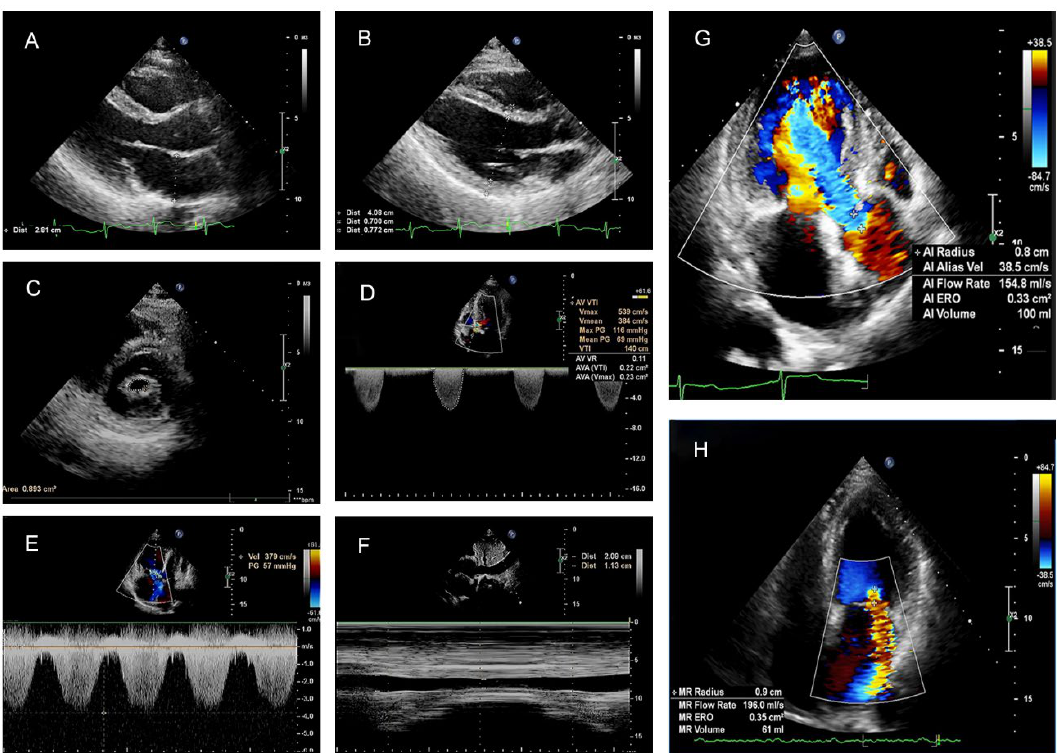
Figure 2. Representation of measured values based on echocardiographic views. ( A ) The measure- ments of the left atrial in parasternal left ventricular long axis (PLAX) view. ( B ) The measurements of the interventricular septum (IVS), left ventricular posterior wall (LVPW), and left ventricular end-diastolic diameter (LVEDD) in PLAX view. ( C ) Measurement of the mitral valve area in a patient with rheumatic heart disease; the mitral valve area was manually outlined and the mitral valve area is 0.89 cm 2 . ( D ) The aortic valve area was calculated using continuity equations, and the effective valvar orifice area (EOA) of the aortic valve is 0.23 cm 2 . ( E ) A continuous wave Doppler was used to measuring the end-expiration peak velocity of the tricuspid regurgitant (TR) jet. ( F ) The IVC size was measured in M-mode at the subcostal window. The IVC—CI (inferior vena cava collapsibility index) was calculated as follows: IVC-CI = [(IVC diameter in expiration—ICV diameter in inspiration)/ (IVC diameter in expiration)] × 100. Right atrial pressure (RAP) was estimated from the IVC-CI. ( G ) Quantitative assessment of aortic regurgitation using the proximal isovelosity surface area method (PISA). The effective regurgitant orifice area (EROA) is 0.33 cm 2 and the regurgitant volume (RV) is 100 mL. ( H ) Quantitative assessment of mitral regurgitation by PISA. The EROA is 0.25 cm 2 and the RV is 61 mL.